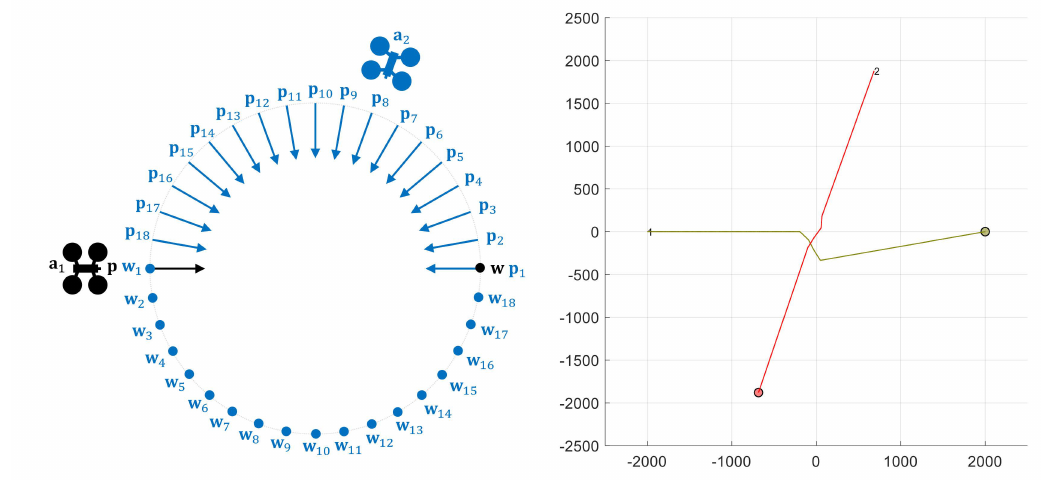
Figure 10. Two UAV scenarios: relative path